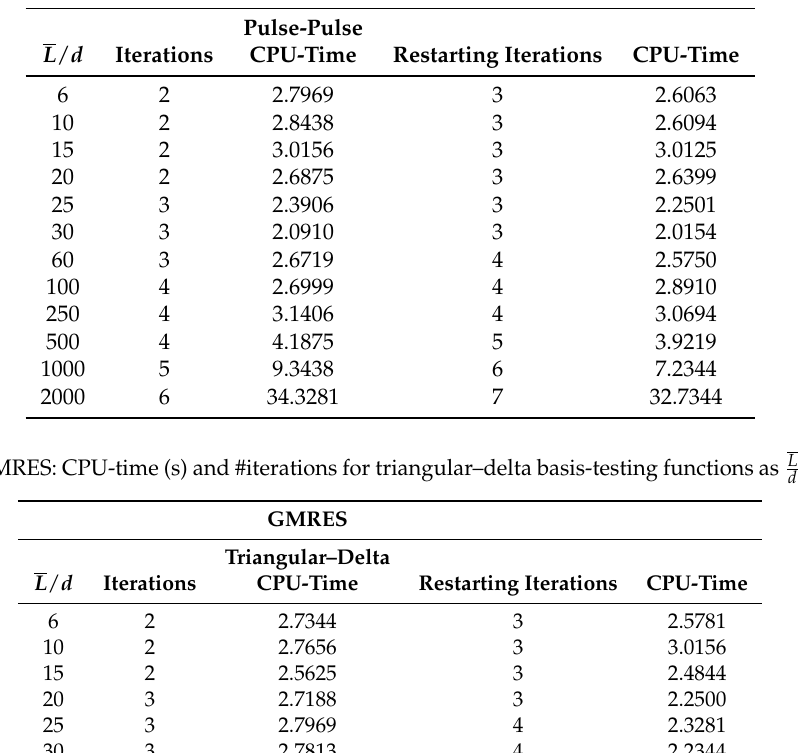
Table 2. GMRES: CPU-time (s) and #iterations for each pair pulse–pulse basis-testing functions as L changes. d